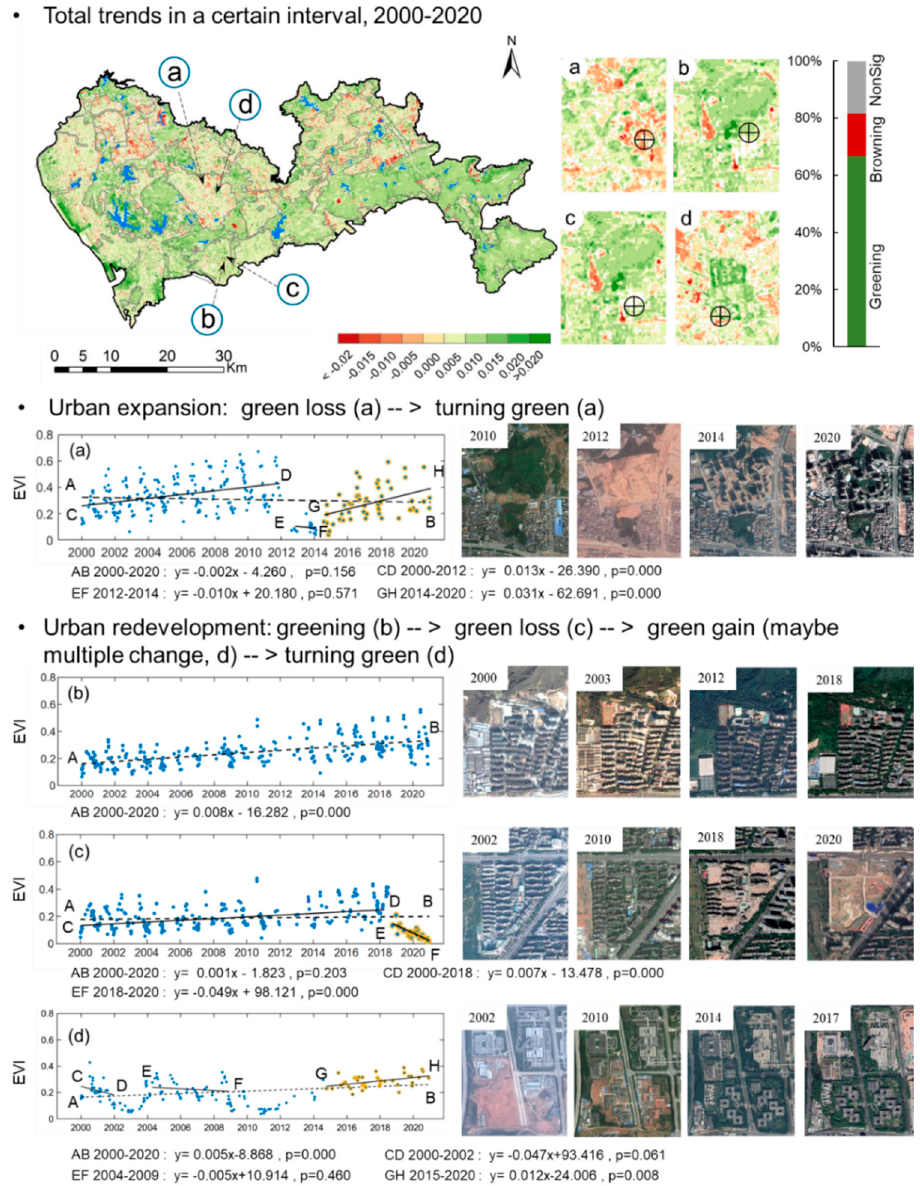
Figure 3. Total trends and process of vegetation greenness along with the urban expansion and internal renewal. a shows the process of green loss, green gain, and turning green along with the urban expansion; b, c, and d show different stages in the process of greenness along with the urban redevelopment. The blue filled dot represents the EVI value of one pixel and the yellow dot is the EVI from the latest change period. The historical very high-resolution image is captured from Google Earth.